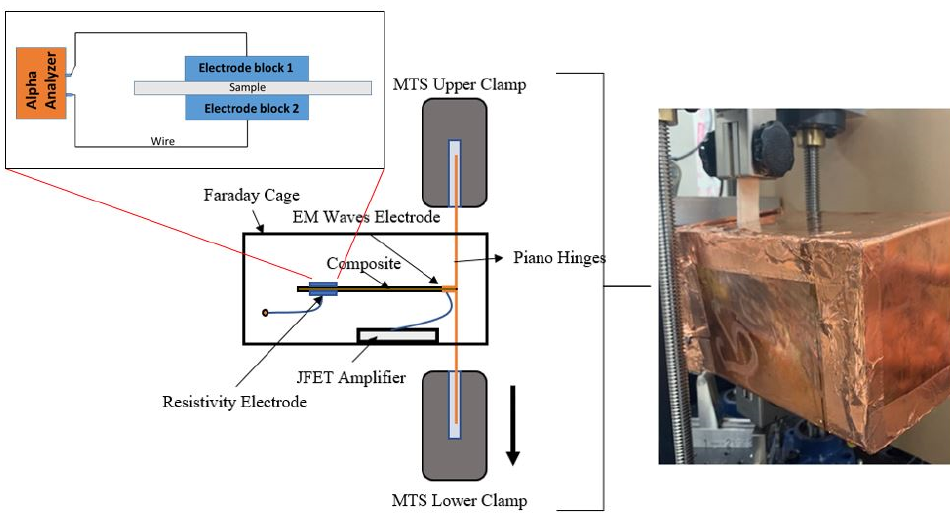
Figure 4. Mechanical testing setup for all composite specimens in this